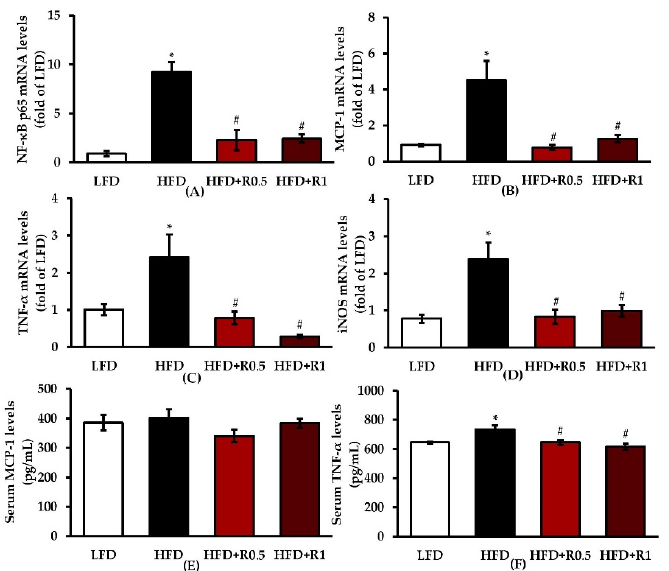
Figure 4. Effects of RRBE on pro ‐ inflammatory gene expression in eWATs and serum inflammatory mediators of HFD ‐ fed mice: ( A ) NF ‐κ B p65 mRNA expression; ( B ) MCP ‐ 1 mRNA expression; ( C ) mediators of HFD-fed mice: ( A ) NF- κ B p65 mRNA expression; ( B ) MCP-1 mRNA